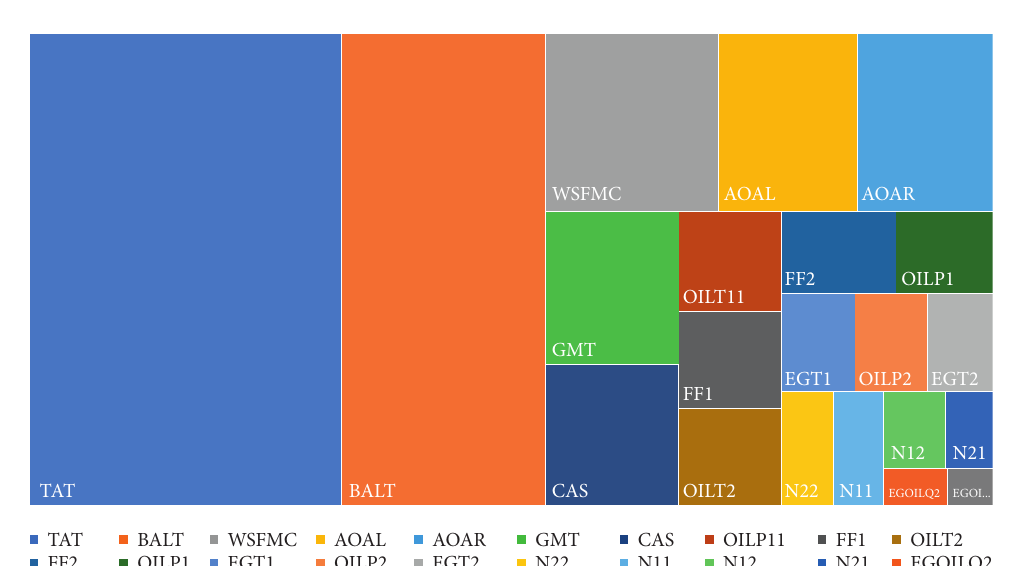
Figure 7: The importance of each characteristic of R